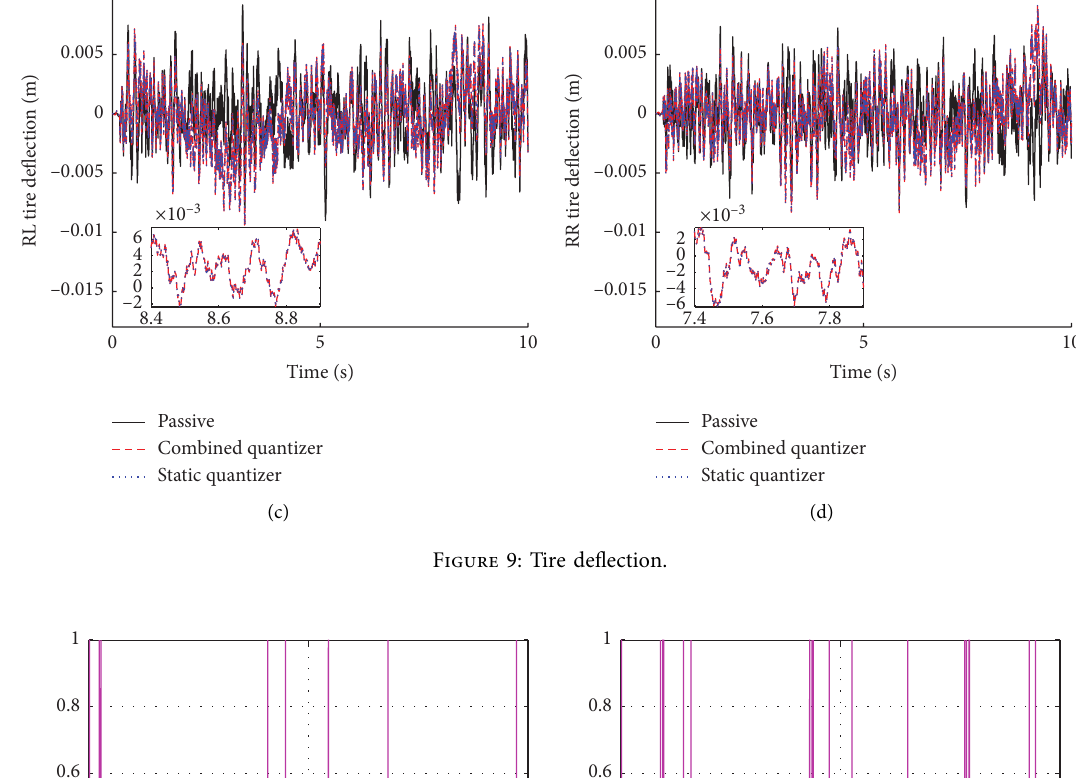
Figure 9: Tire deflection.